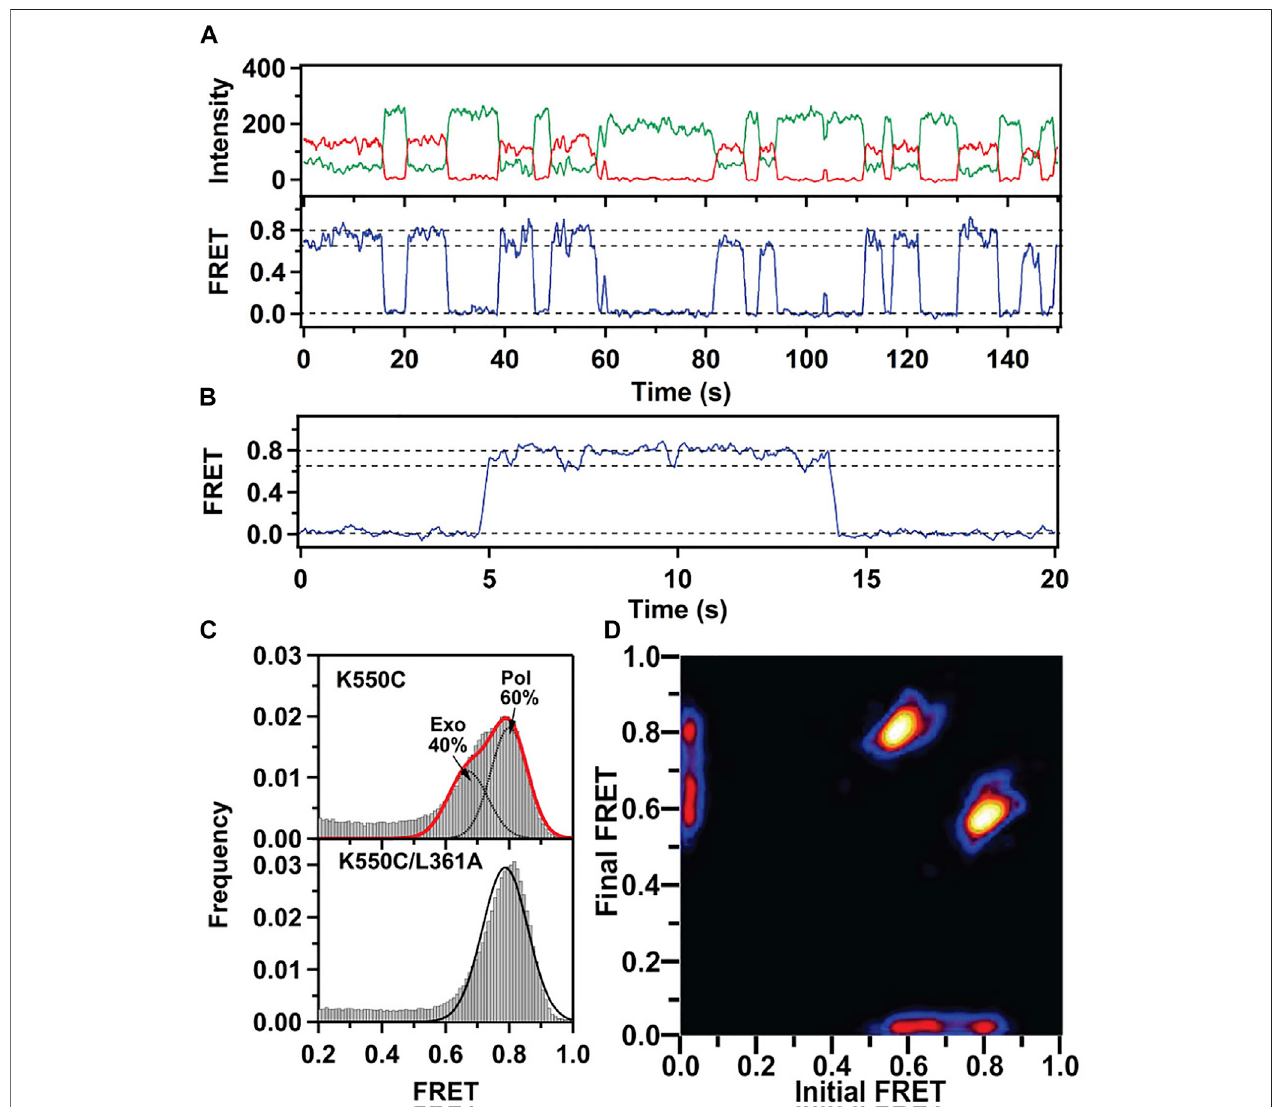
FIGURE 5 | smFRET data for KF interacting with mismatched DNA. (A) Representative donor intensity (green), acceptor intensity (red) and FRET ef fi ciency (blue) trajectories. (B) Expanded view of a single encounter between KF and DNA. (C) FRET ef fi ciency histograms compiled from multiple traces. (D) Plot of transition probability density. Reproduced from reference (Lamichhane et al., 2013) with